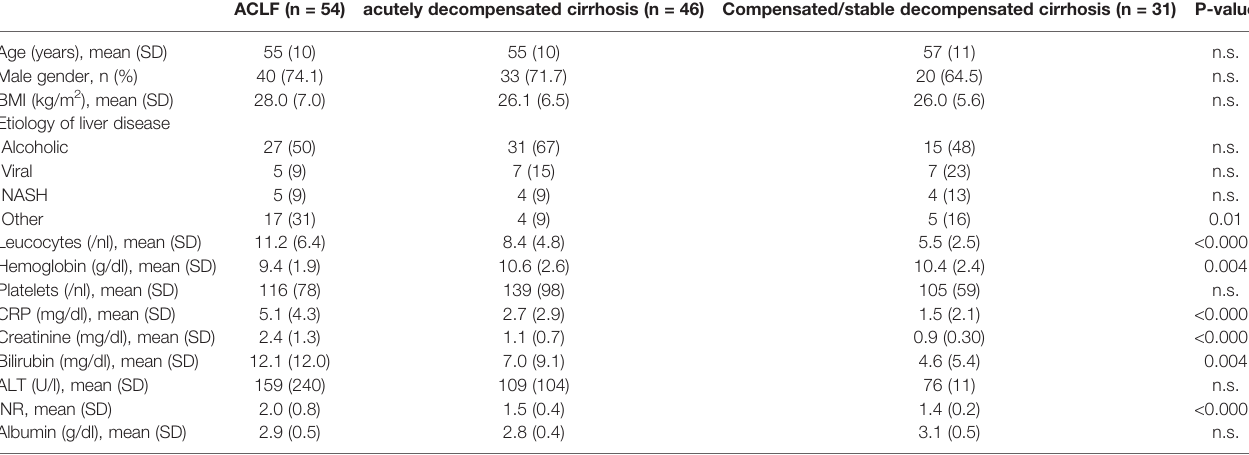
TABLE 1 | Baseline characteristics of included